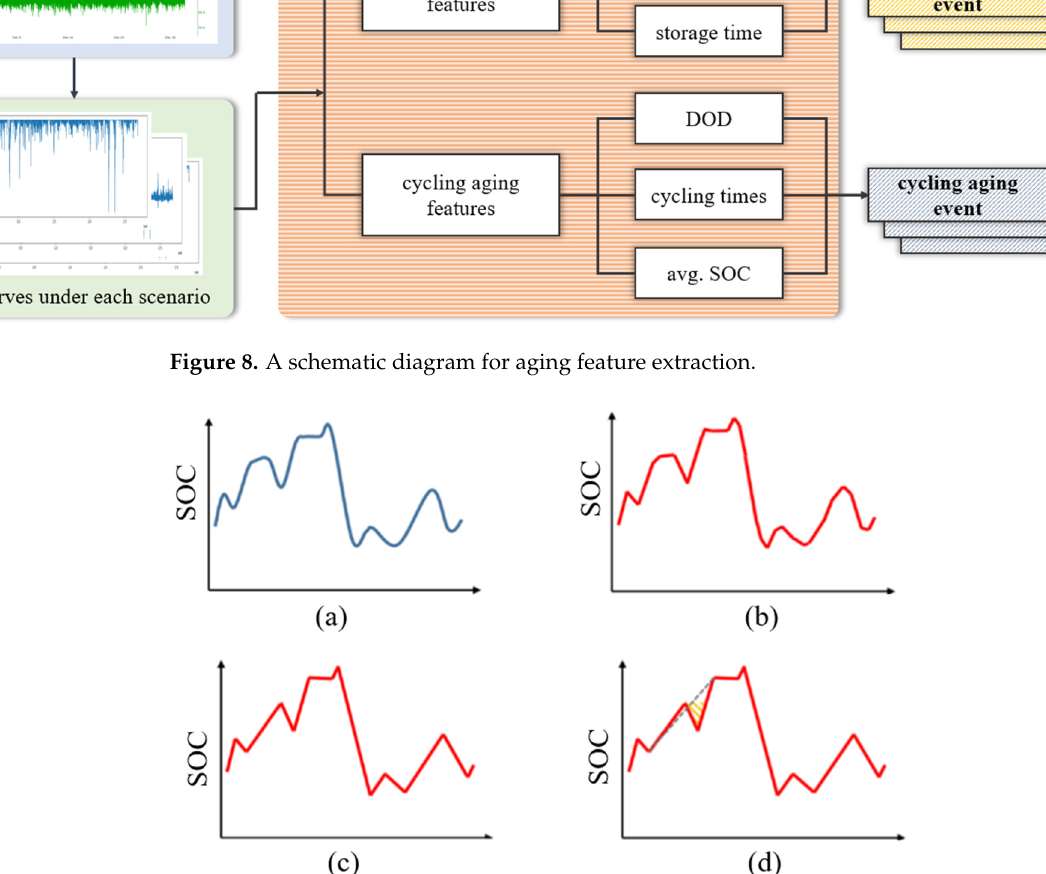
Figure 9. A schematic diagram of the applied rainflow counting method of SOC. ( a ) Raw SOC curve. ( b ) Curve After filtering continuous values. ( c ) Only the relative peaks and valleys are left, and the values between the peaks and valleys are removed. ( d ) Start rainflow cycle counting method.